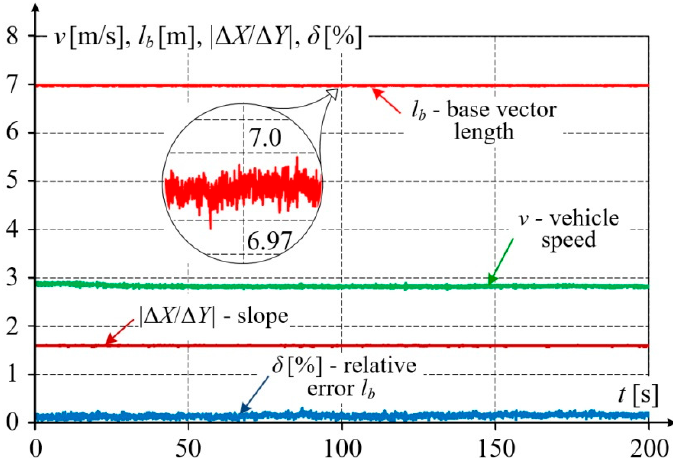
Figure 8. Waveforms of qualitative parameters of measurements on a straight railway track section—determined for base vector 𝐴𝐵(cid:4652)(cid:4652)(cid:4652)(cid:4652)(cid:4652)⃗ .